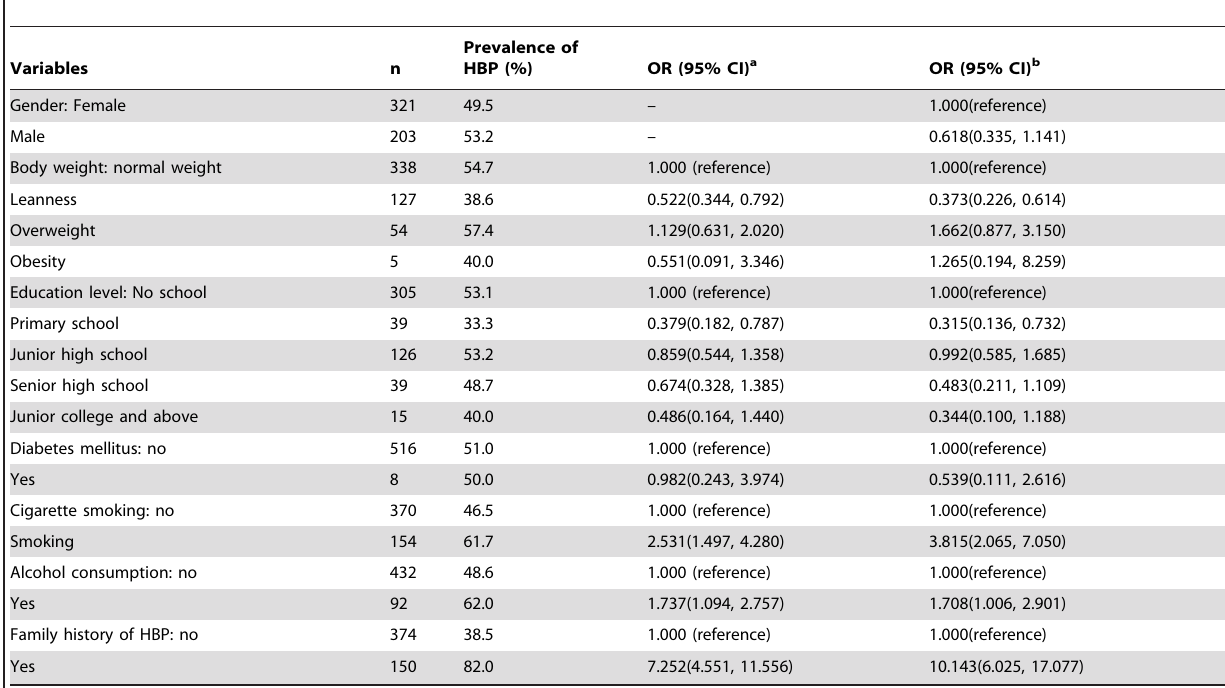
Table 6. Factors associated with the prevalence of hypertension from multivariate logistic regression models in age group 70–79 (N=